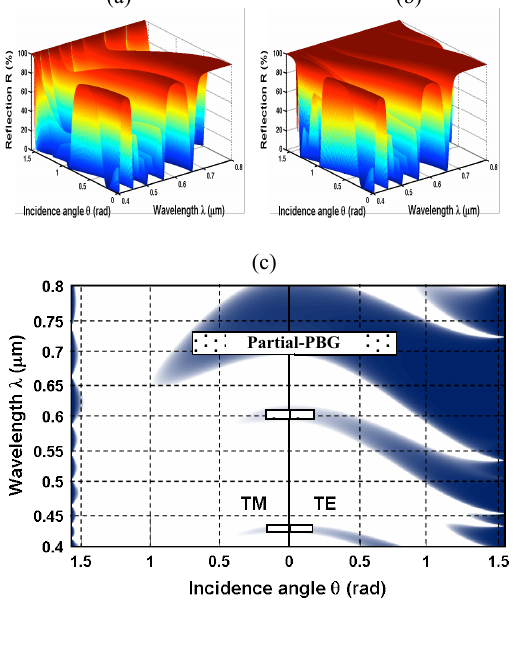
Figure 7 : (a) Transmission spectra of the photonic multilayer system according to the distribution of Period-Doubling for the 5th generation PD(5), mode TM. (b) Transmission spectra of